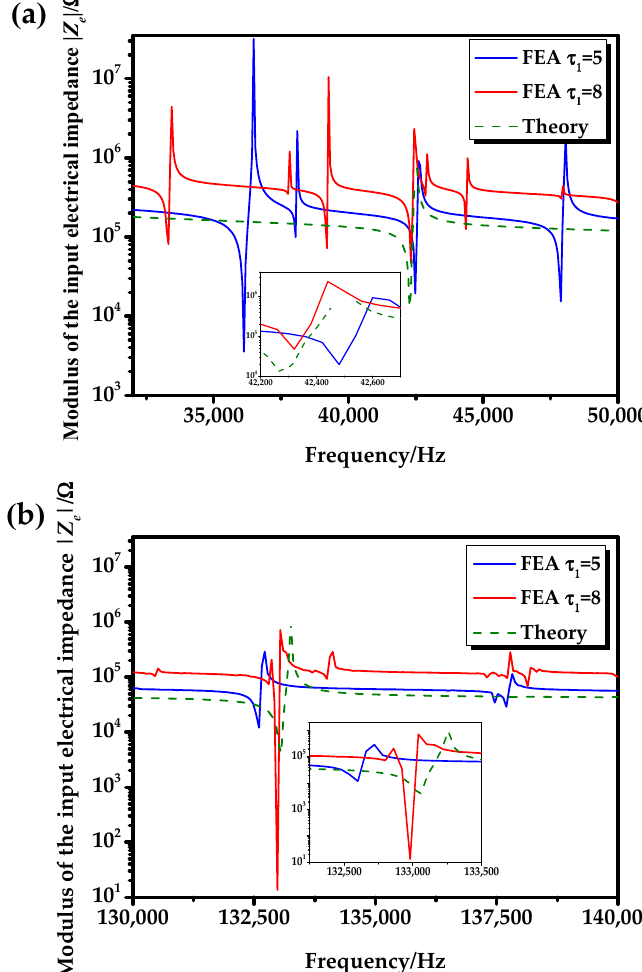
fundamental mode.